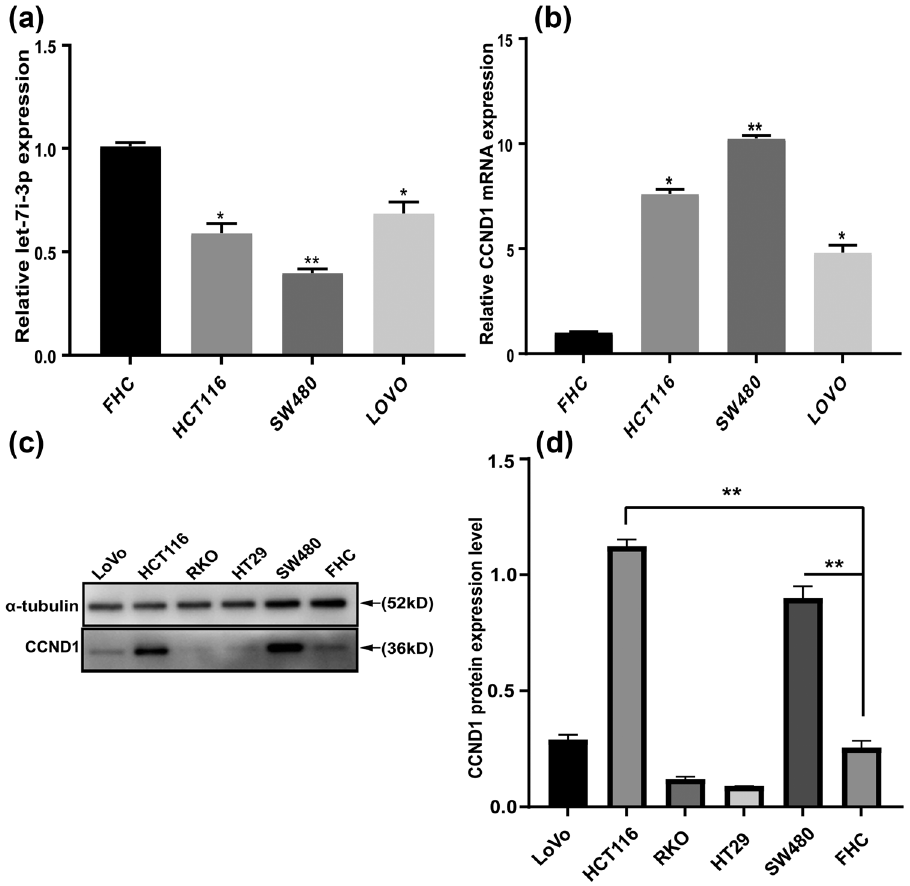
Figure 1: The expression of let - 7i - 3p and CCND1 in CRC cells. ( a ) The expression of let - 7i - 3p in four cell lines was determined by qRT - PCR. ( b ) The expression of CCND1 mRNA in four cell lines. ( c ) The expression of CCND1 protein in six cell lines was determined by western blot. ( d ) Quanti fi cation of CCND1 was normalized to α - tubulin. * P < 0.05 and ** P <